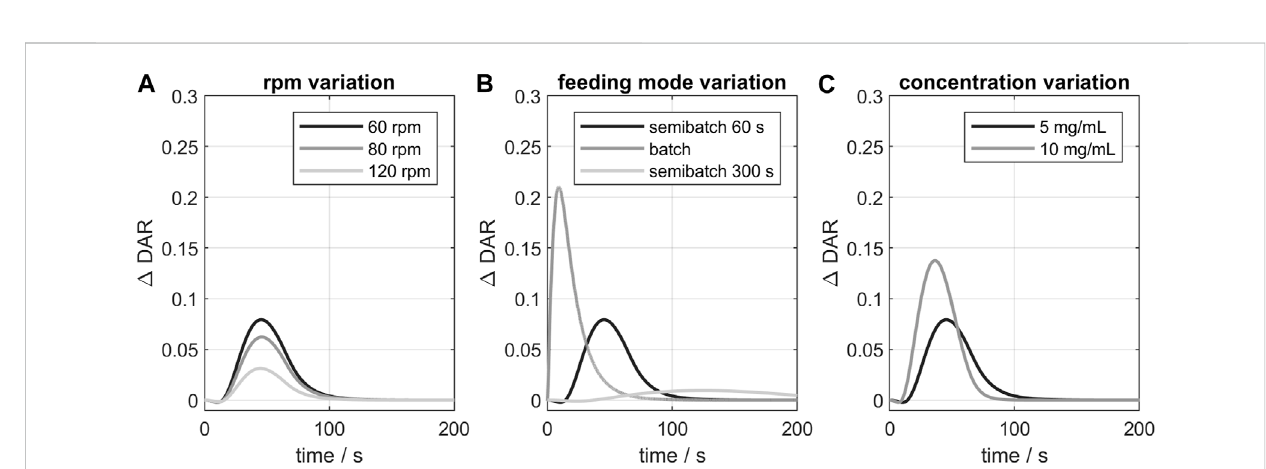
FIGURE 7 In fl uence of varying process parameters on the Δ DAR of 3D- and 0D-model exemplarily for GST-2: variation of (A) stirrer speed, (B) feeding mode, (C) mAb concentration. The black curve is the reference condition (60 rpm, 60s feeding time, 5 mg/mL + 5x payload excess).